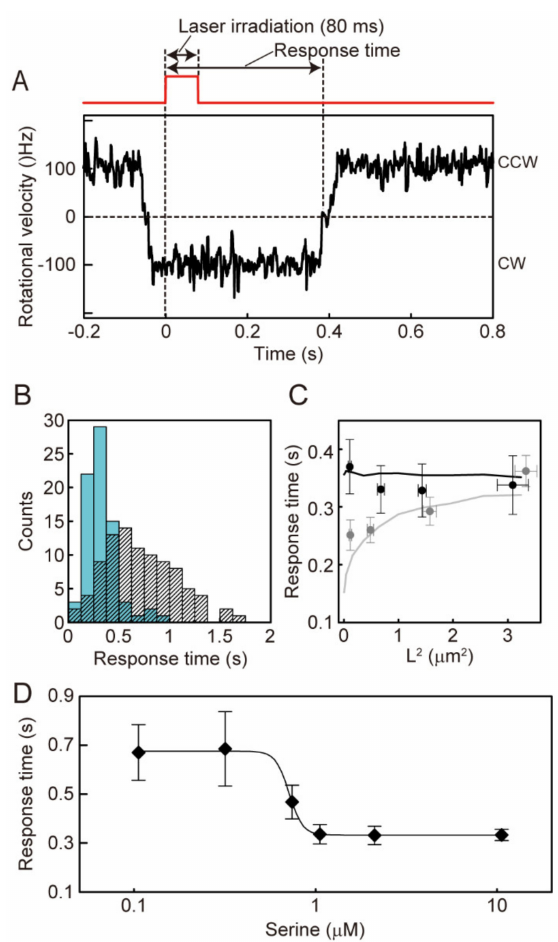
Figure 4. Measurement of the response to an instantaneously applied attractant stimulus of photoreleased serine. ( A ) Typical response of a CheA S − cell after laser irradiation in the presence of 10.6 µ M released serine (1000 µ M of caged serine was contained in motility bu ff er). The laser shutter was open at 0 s for 80 ms (red line) immediately following a CCW-to-CW switching event. The interval between the initiation of laser irradiation and the first CW-to-CCW switch was defined as the response time. ( B ) Histogram of the response time of CheA S − cells that exhibit monopolar and bipolar localization of GFP-CheW. Blue bars show the histogram of the response times obtained from 76 cells exposed to 10.6 µ M released-serine. Gray hatched bars delineate the histogram of the CW duration obtained from 96 trials for 76 cells in the presence of 1000 µ M caged serine without laser irradiation. ( C ) The relationship between the response time and the square of the distance from the polar receptor array to motor (L 2 ). Black plots show the relationship for CheA S − cells that show monopolar localization of GFP-CheW. Error bars show the standard error of the mean. The response times in the presence of 10.6 µ M released-serine are shown (n = 45 cells). The black line is the estimation of the response time from the simulation shown in Figure 5C when the rate constant for dephosphorylation of CheY-P by CheZ (k 3 ) is 1.6 × 10 6 M − 1 s − 1 . The experimentally measured response time of CheA S − cells was well fitted by this value of k 3 . Gray plots show the relationship for CheA S + cells that show monopolar localization of GFP-CheW (the data were reused from reference [19] with permission). The gray line is the estimation of the response time from the simulation shown in Figure 5B when k 3 is 4.0 × 10 6 M − 1 s − 1 . The experimentally measured response time of CheA S + cells was well fitted by this value of k 3 . ( D ) Relationship between the response time of CheA S − cells and the concentration of released-serine. The response times for 0.11 (n = 9 cells), 0.32 (n = 9 cells), 0.74 (n = 9 cells), 1.1 (n = 11 cells), 2.1 (n = 12 cells), and 10.6 (n = 44 cells) µ M released serine are shown. The black line shows the fitted curve using the Hill equation. Error bars show the standard error of the